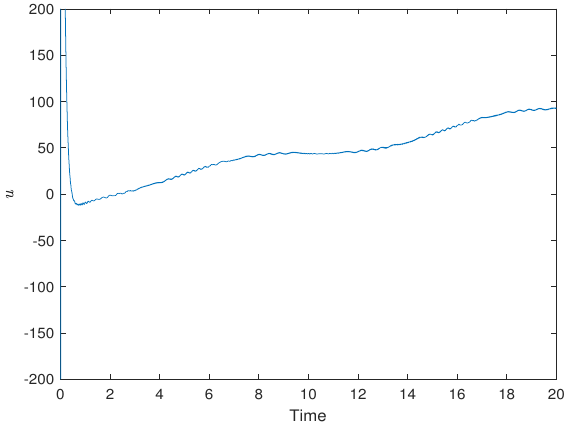
Figure 6. The controller u of the proposed method.